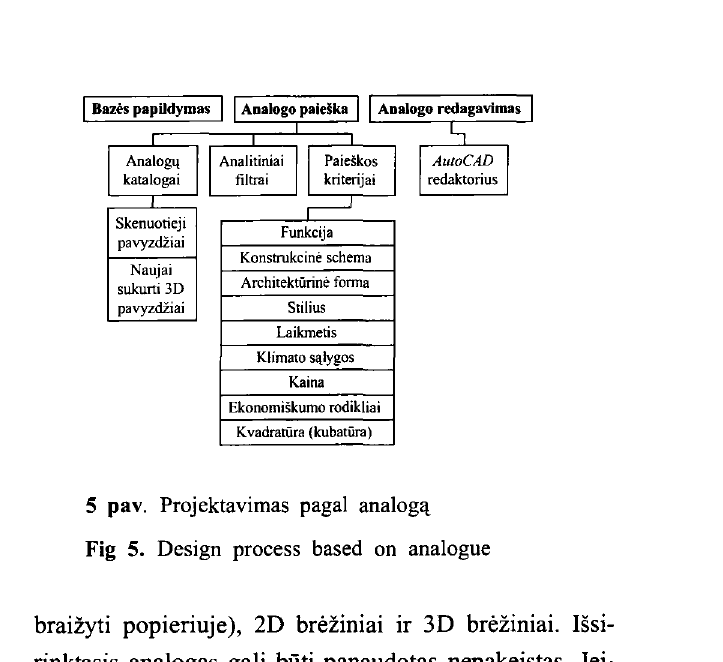
Fig 5. Design process based on analogue braizyti popieriuje ), 2D breziniai ir 3D breziniai. ISsi rinktasis analogas gali biiti panaudotas nepakeistas. Jei gu reikia ji keisti, jis koreguojamas ir naujasis varian pavyzdys.